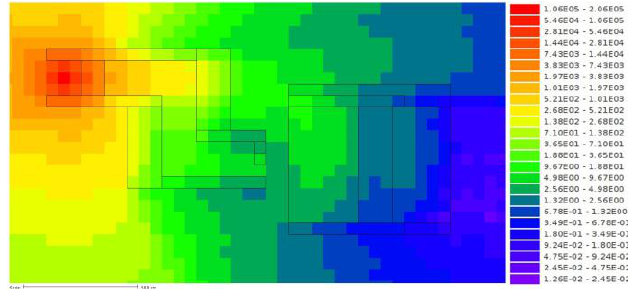
Fig. 4. Total neutron flux - SCALE [par.cm -2 .s -1 ]